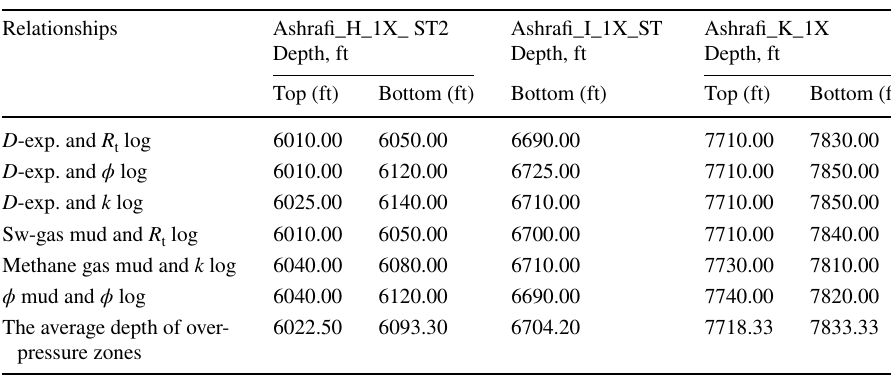
Table 2 The summarized relationships to detect overpressure